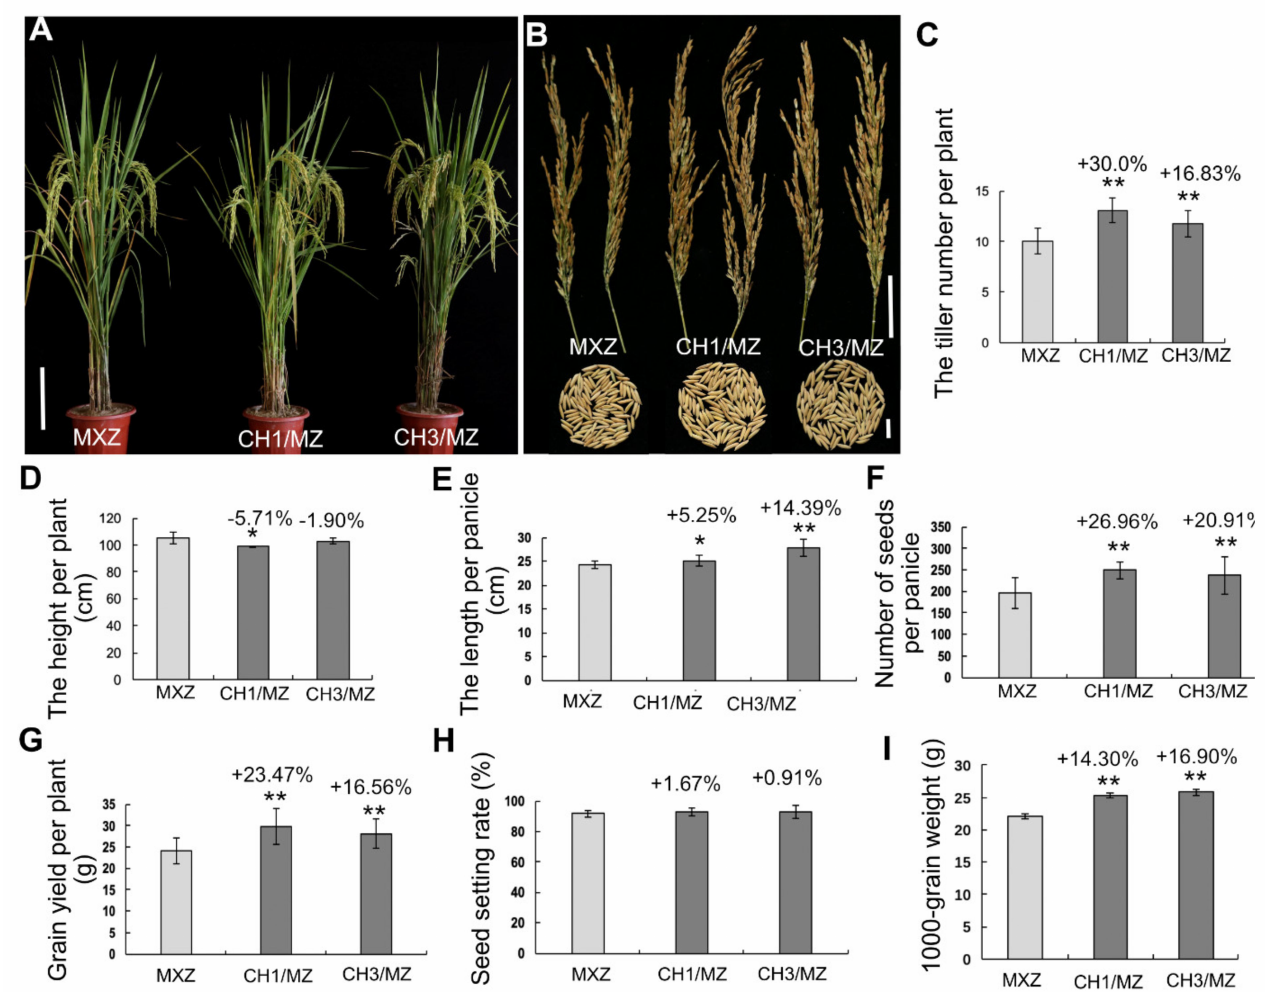
Figure 2. Yield traits of MXZ and OsHXK1-Cas9 plants seeded in the fall. ( A ) Images of MXZ, CH1/MZ, and CH3/MZ plants at the flowering stage. Bar = 20 cm. ( B ) Comparisons of panicles and 100 grains of MXZ, CH1/MZ, and CH3/MZ plants. Bar = 5 cm (top), 2 cm (bottom). ( C ) Tiller number of MXZ, CH1/MZ, and CH3/MZ plants. ( D ) Height of MXZ, CH1/MZ, and CH3/MZ plants. ( E ) Length per panicle of MXZ, CH1/MZ, and CH3/MZ plants. ( F ) Number of grains per panicle of MXZ, CH1/MZ, and CH3/MZ plants. ( G ) Single-plant yield of MXZ, CH1/MZ, and CH3/MZ plants. ( H ) Seed setting rate of MXZ, CH1/MZ, and CH3/MZ plants. ( I ) 1000-grain weight of MXZ, CH1/MZ, and CH3/MZ plants. The data are the means ± SDs; *, 0.01 ≤ p < 0.05; **, 0.001 ≤ p < 0.01 according to Student’s t